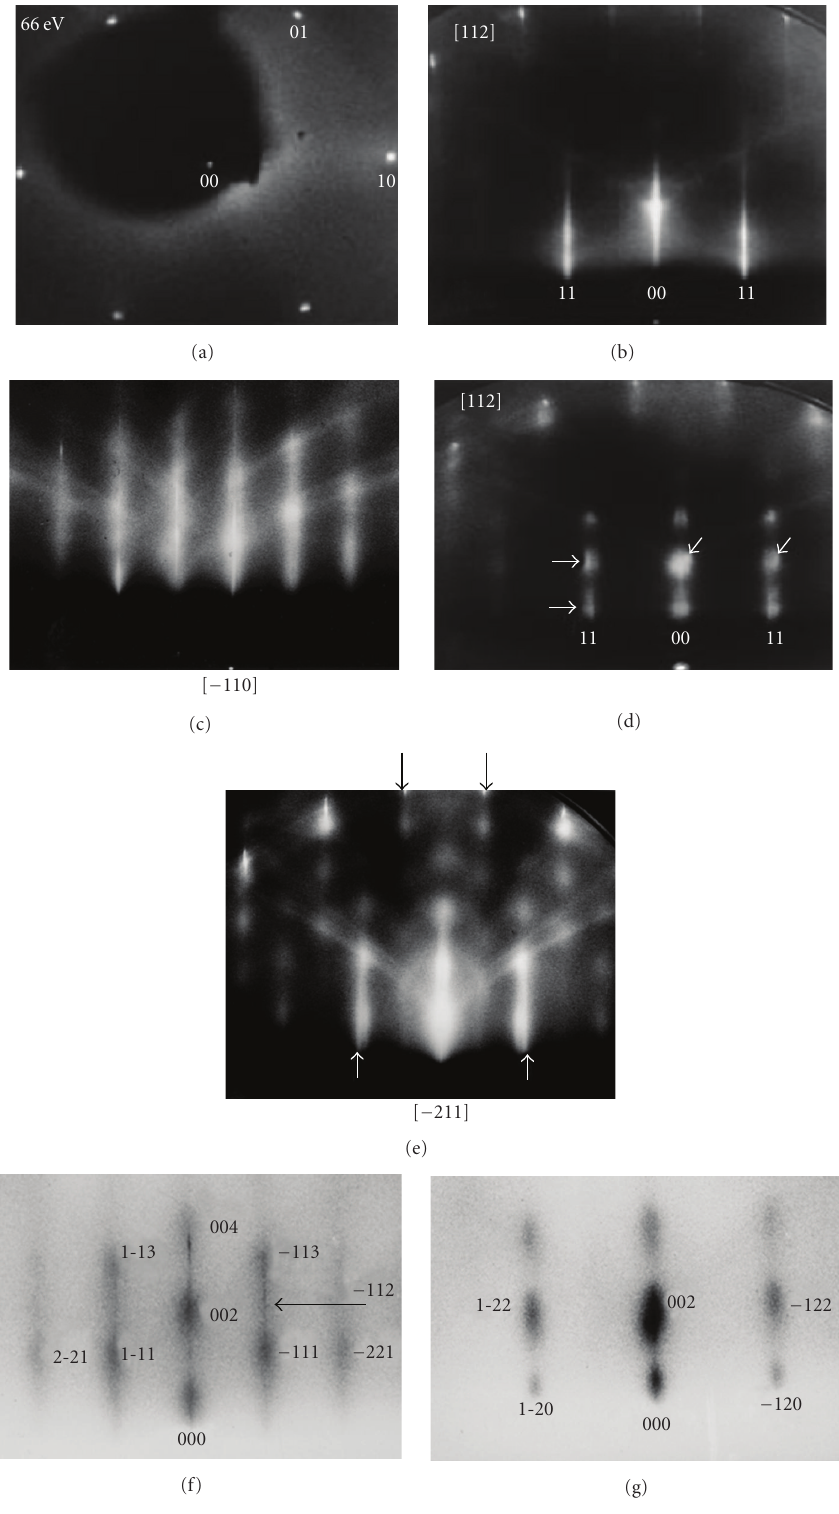
Figure 4: (a) LEED (66 eV) and (b) the RHEED ([112] azimuth) patterns for an Ru-deposited Pt(111) electrode surface (0.25ML); the RHEED patterns (c) ([110]) and (d) ([112]) for an Ru-deposit modified Pt(111) electrode surface with the Ru coverage of 0.64, showing intensity modulation and satellite reflections besides the Pt substrate reflections; (e) the RHEED pattern ([ − 211]) obtained at another position of the electrode surface, where both the Pt- and satellite-reflections are clearly resolvable at the first- and zero-Laue zones; the RHEED patterns (f) ([ − 110]) and (g) ([ − 211]) for an Ru-modified Pt(111) electrode surface with ∼ 1 ML